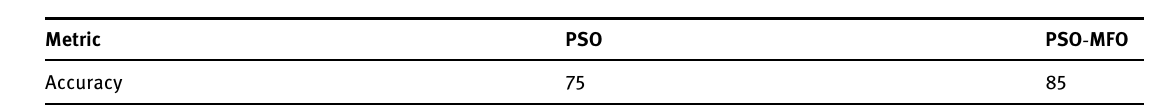
Table 5: Overall performance comparison